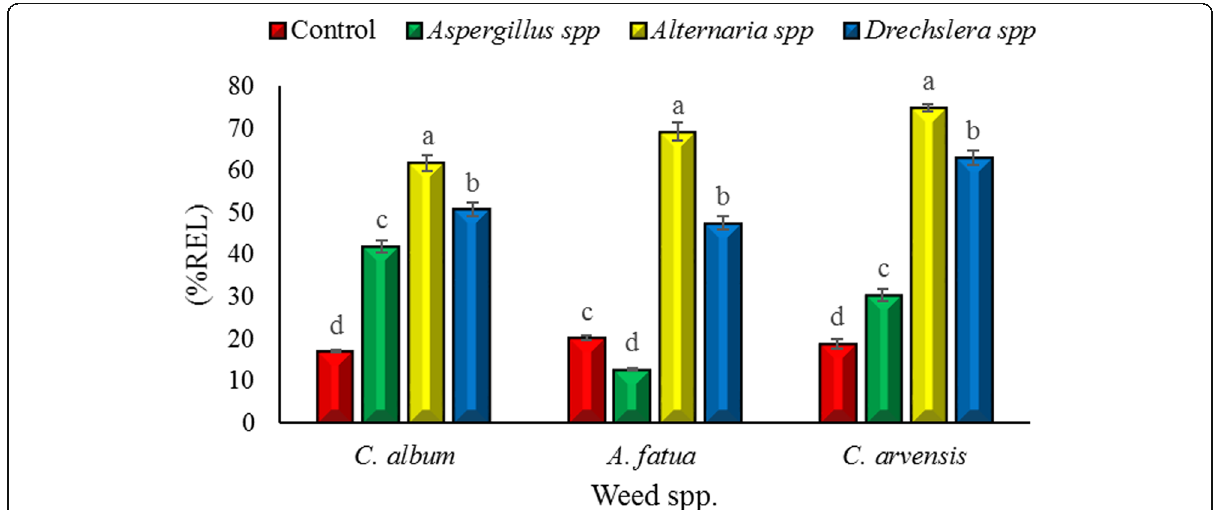
Fig. 2 Effect of cultural filtrates of endophytic fungi on the relative electrolyte leakage of C. album , A. fatua , and C. arvensis . Different letters show significant differences of treatments in each weed